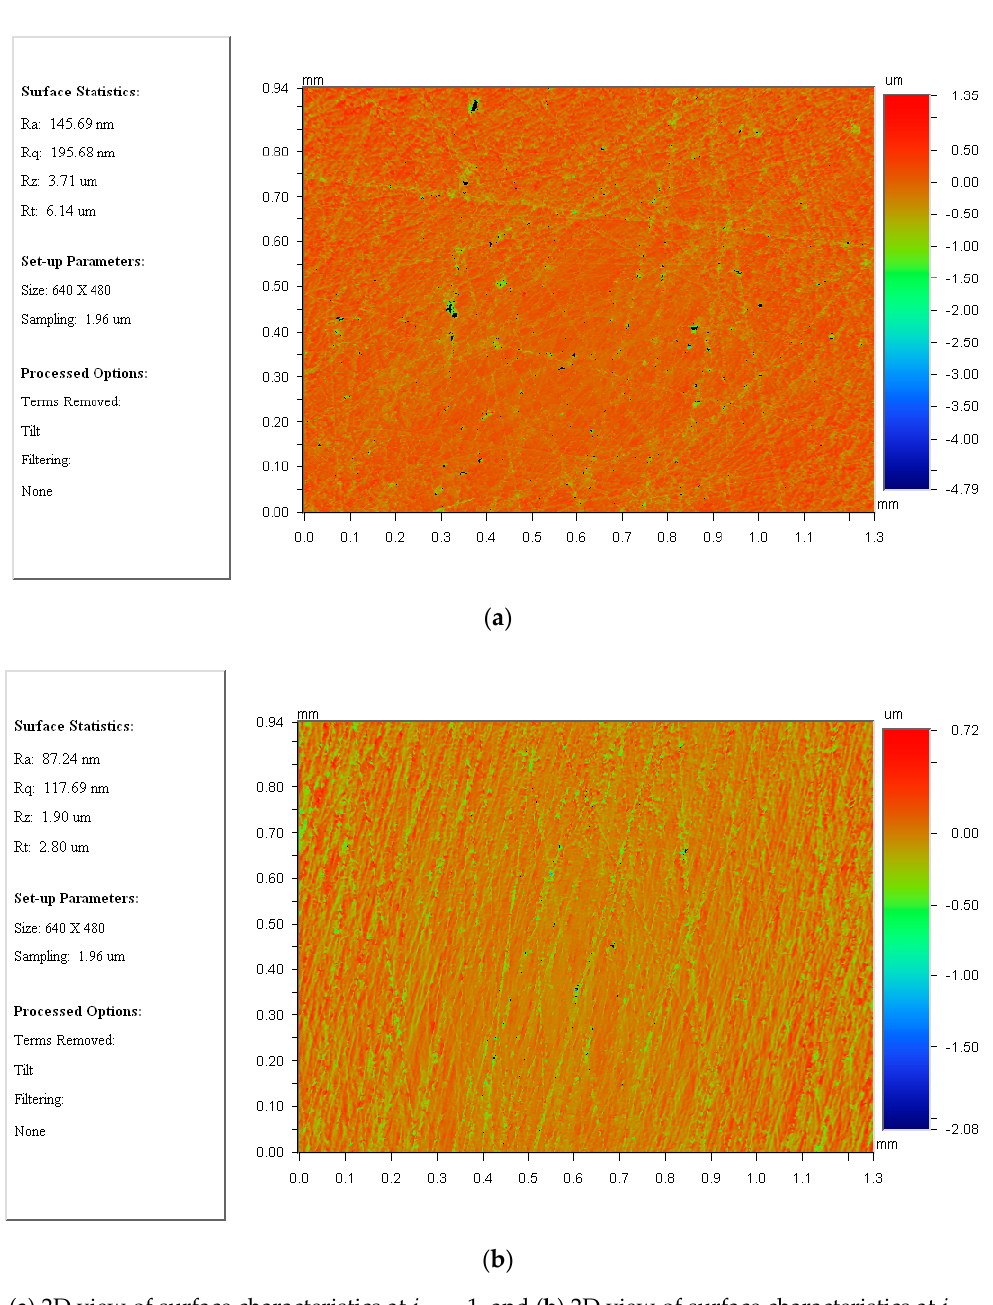
Figure 14. ( a ) 2D view of surface characteristics at i pw = 1, and ( b ) 2D view of surface characteristics at i pw = 0.3819…, respectively. Table 2. Comparison between surface characteristics at i pw = 1 and i pw = 0.3819….